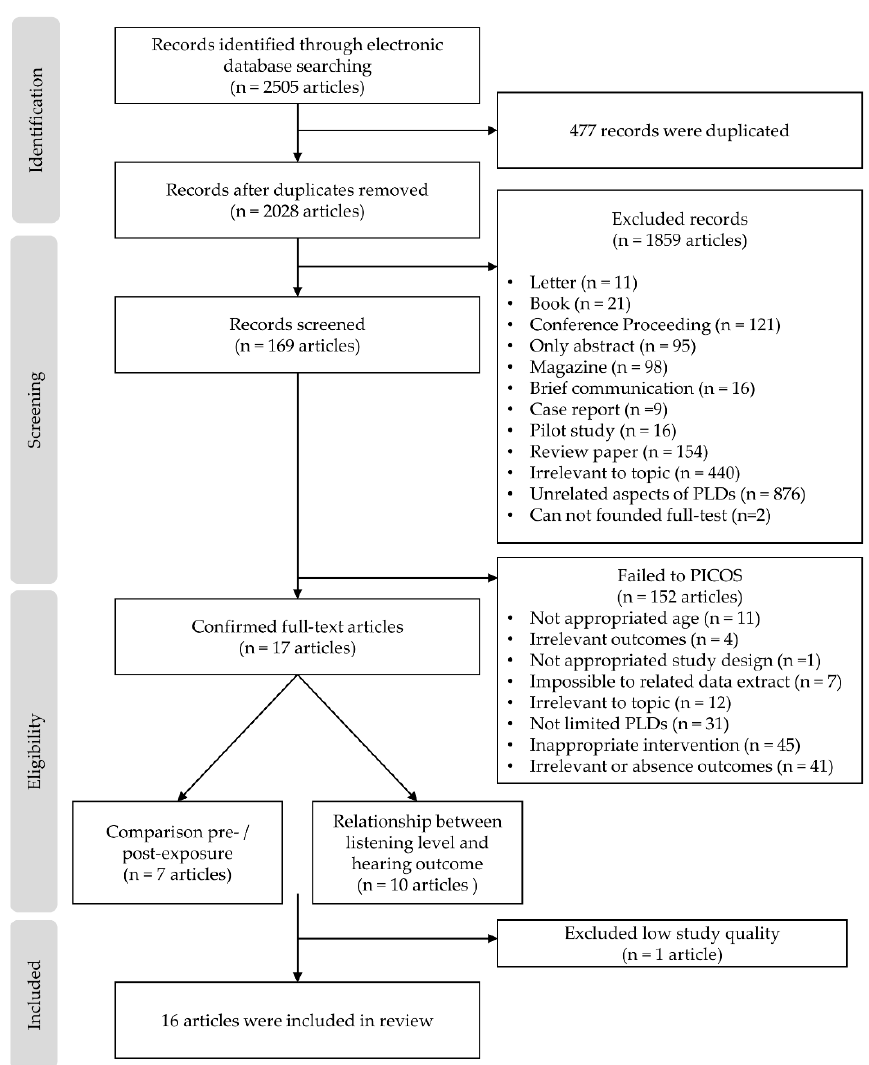
Figure 1. Article selection process using the inclusion and exclusion criteria for the present study. Notes: PICOS, participants, intervention, control, outcomes, and study design.PLD: personal listening device.